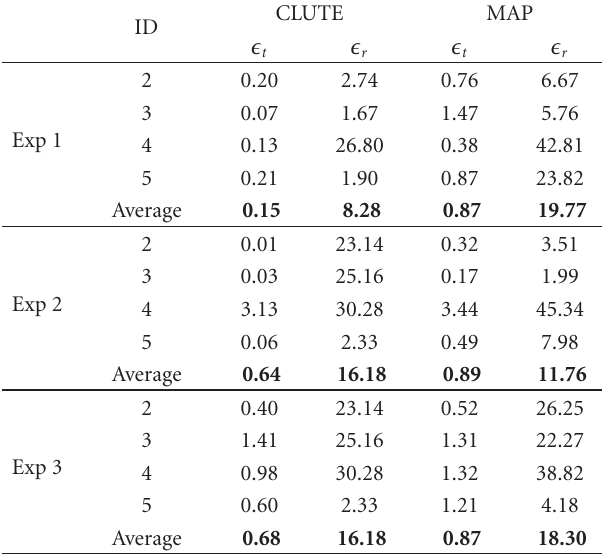
Table 9: 8-camera network: comparison between CLUTE and MAP in case of the failure of 3 cameras.